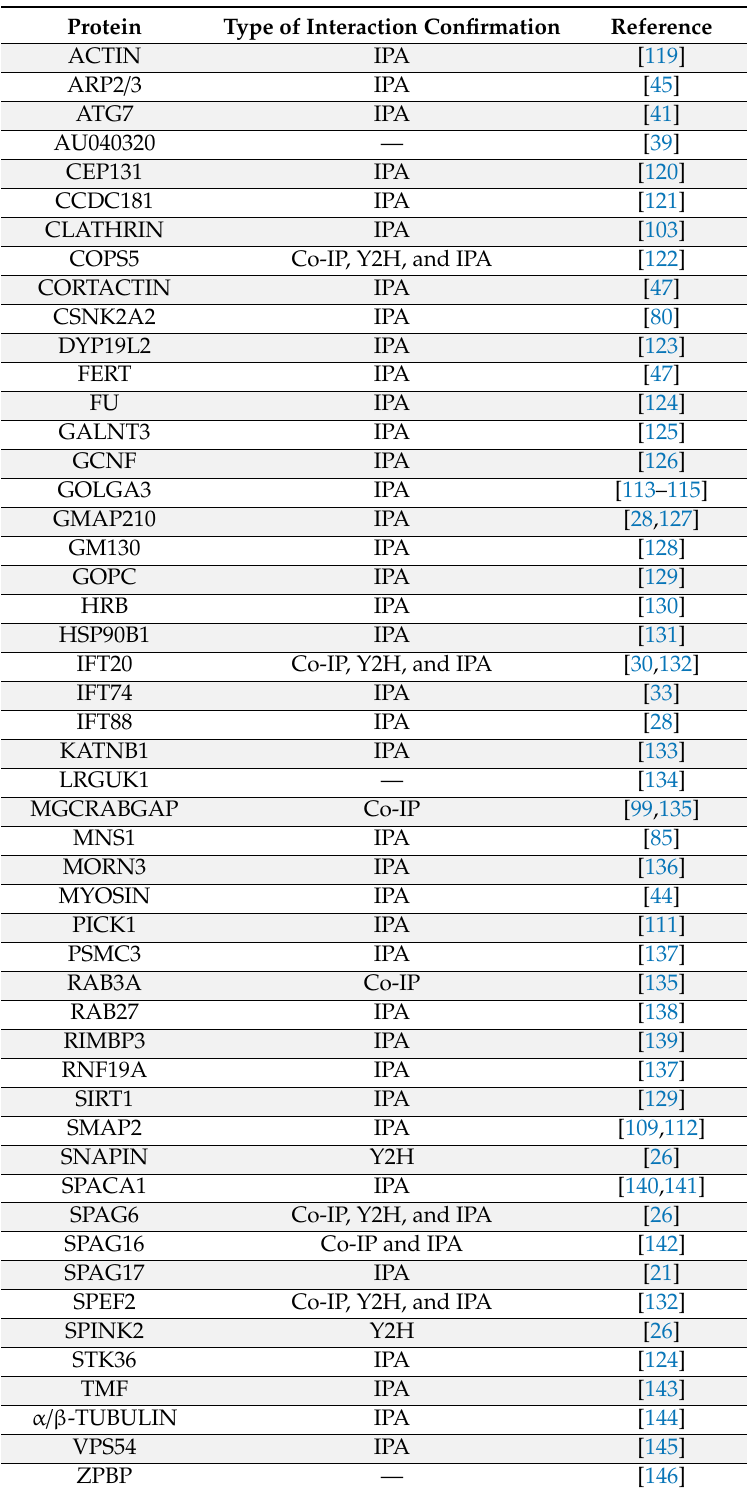
Table 3. List of proteins known to localize to the Golgi, Golgi vesicles, acrosome and / or acroplaxome, whose interacting partners were confirmed by immunoprecipitation (IP), co-immunoprecipitation (co-IP), yeast two-hybrid (Y2H) screen and / or IPA database (a ffi nity chromatography, co-IP, anti-bait co-IP, enzyme activity assay, in situ proximity ligation assay, IP, liquid chromatography mass spectrometry, pulldown assay, tandem a ffi nity purification, Western blotting, and yeast two-hybrid screen). Species were limited to human, mouse, and